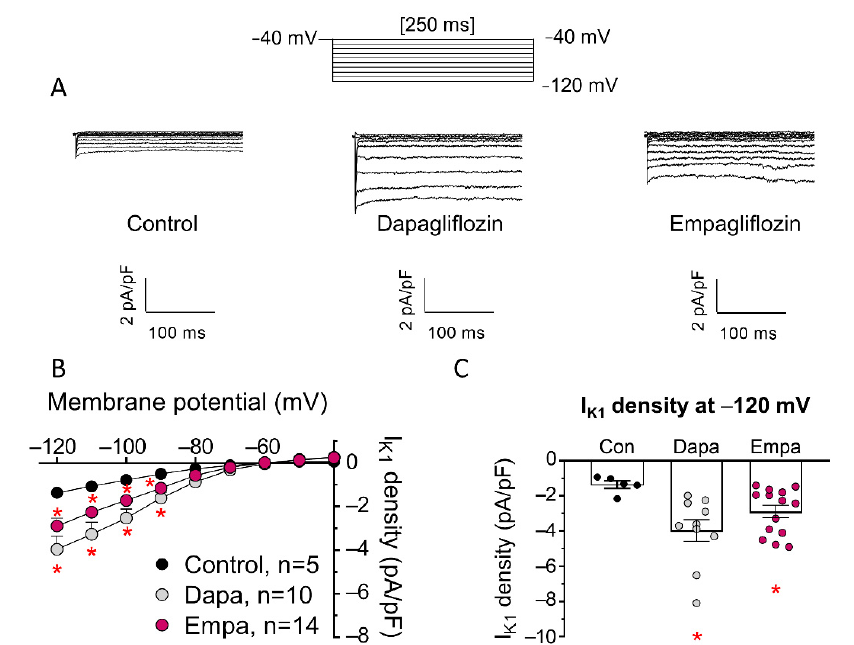
Figure 3. Incubation with dapa and empa increased I K1 recorded in hiPSC-CMs. ( A ) I K1 traces recorded in three different hiPSC-CMs: incubated with dapa or empa (1 µM, 24-h) or not incubated (control). ( B , C ) Current density-voltage relationships ( B ) and mean density for I K1 recorded at − 120 mV ( C ) in hiPSC-CMs incubated with dapa or empa or not incubated. In B, each point is the mean ± SEM of the “n” experiments indicated in the figure, and in ( C ), each bar shows the mean ± SEM of the “n” experiments, and each point represents one experiment. * p < 0.05 vs. control. empa on I Na and I K1 . Table 1. Effects of dapa and empa on time and voltage dependence of peak I Na activation and inac- tivation. CHO = Chinese hamster ovary. hiPSC-CMs = human-induced pluripotent stem cell-de- rived cardiomyocytes. τ act = time constant of activation yielded from fit of a monoexponential function to peak maximum current. τ finact and τ sinact = fast and slow time constants of inactivation yielded from fit of a biexponential function to peak maximum current decay. V hact and k act = mid- point and slope values of conductance-voltage curves; V hinact and k inact = midpoint and slope values of inactivation curves. Each value represents mean ± SEM of >6 cells/experiments from at least three different dishes in each group. * p < 0.05 vs. control. ANOVA followed by Tukey’s te. hiPSC-CMs Activation